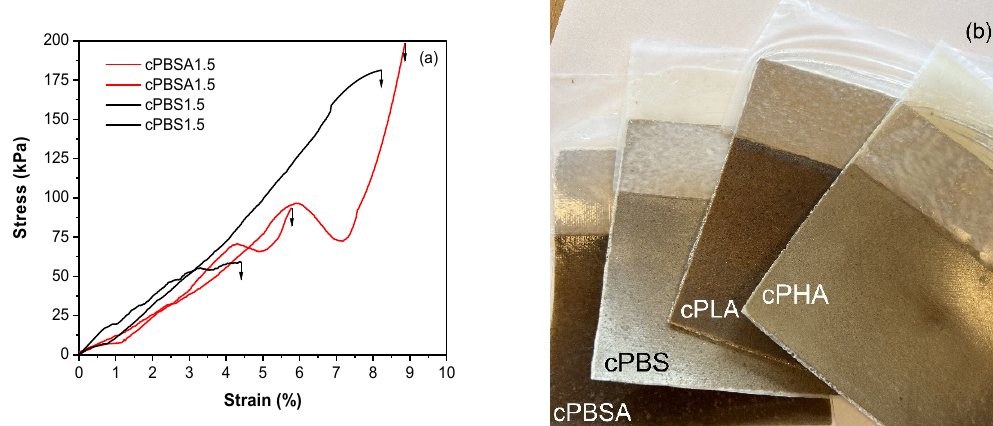
Figure 6. ( a ) Experimental adhesion peel test stress–strain curves for cPBSA1.5 and cPBS1.5 showing the highest and lowest measured values ( b ) picture of prepared laminates for peel test.